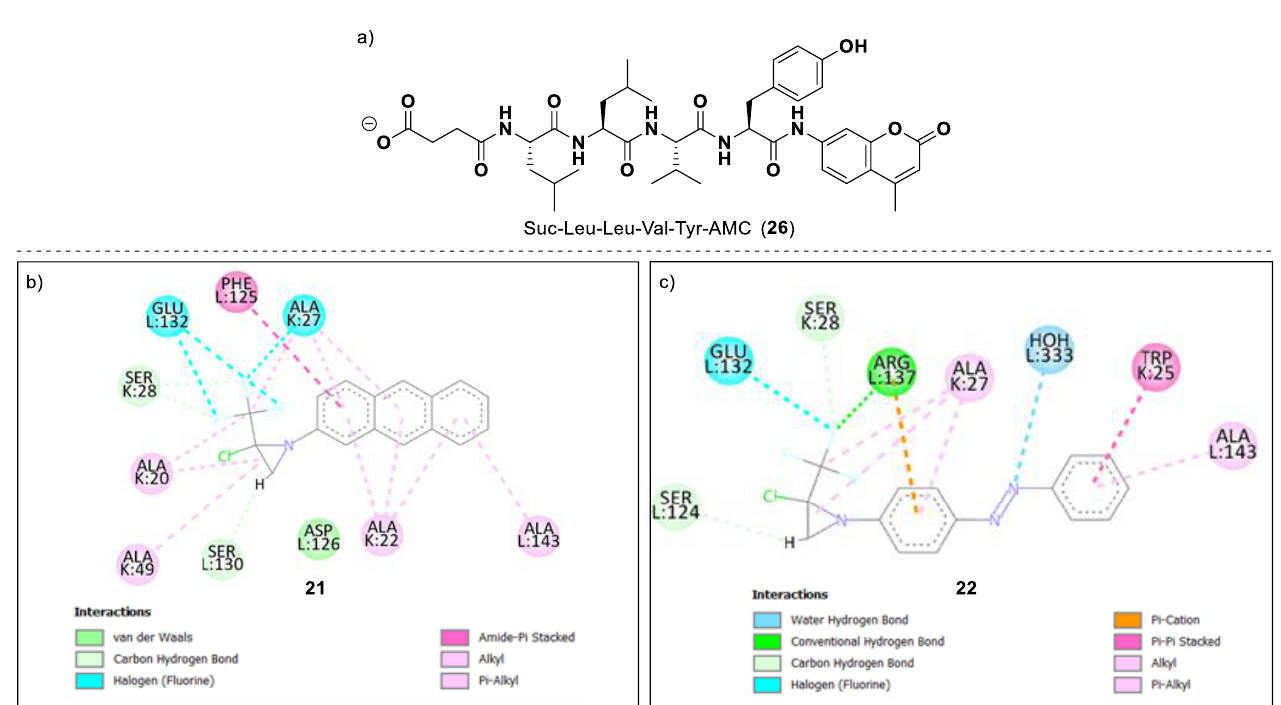
Figure 2. Reference compound structure Suc-Leu-Leu-Val-Tyr-AMC ( 26 ) is used as the positive control ( a ). The 2D poses of CTMAs 21 ( b ) and 22 ( c ), respectively, within the receptor pocket. Table 1. Docking scores, predicted K i on proteasome β 5 subunit of Saccharomyces Cerevisiae (PDB